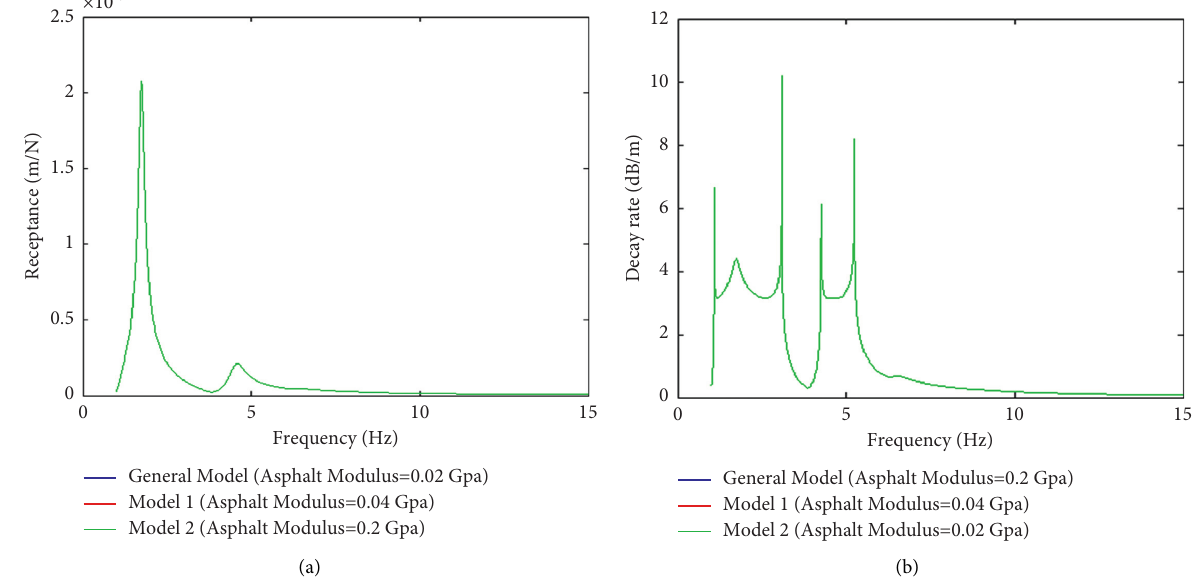
Figure 9: Effect of modulus changes on receptance and the decay rate of ABL: (a) effect of modulus changes on receptance and (b) effect of thickness on the decay rate.